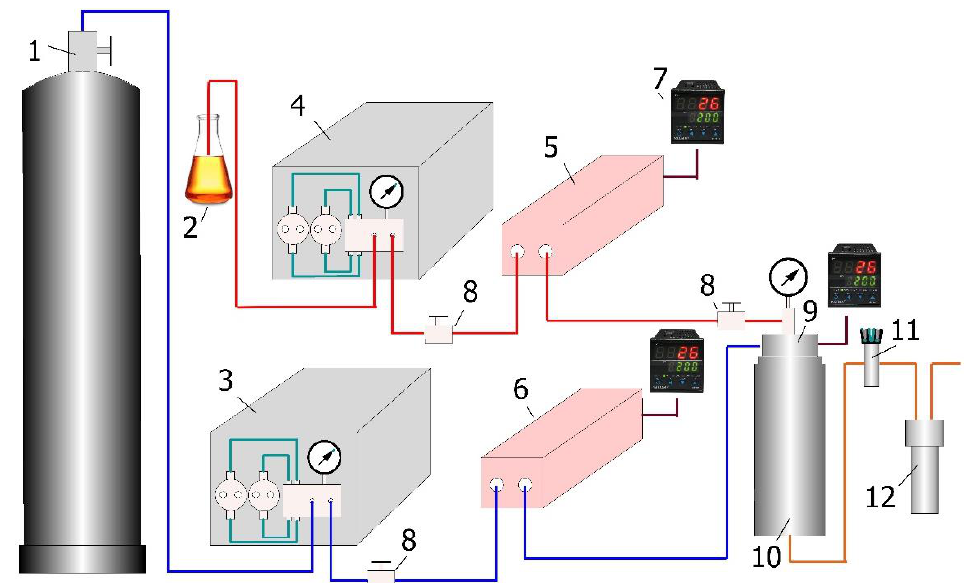
Figure 1. Schematic diagram of the experimental apparatus for dispersion of polymer mixtures using SEDS process: 1—cylinder with CO 2 ; 2—container for a solution (test sample + organic solvent); 3—valve; 4—solution supply pump; 5—CO 2 supply pump; 6—solution heater, 7—temperature con- trol, 8—valve on the solution supply line to the nozzle; 9—coaxial nozzle; 10—reactor (precipitation vessel); 11 — back pressure regulator; and 12 — separator.